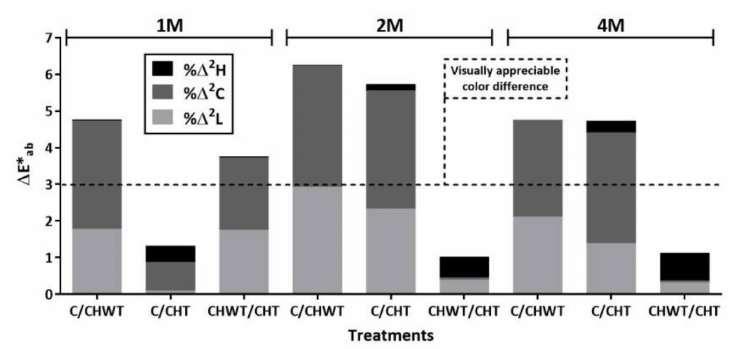
Figure 7. Color differences ( ∆ E* ab ) with the relative contributions of lightness, chroma, and hue (% ∆ 2 L, % ∆ 2 C, % ∆ 2 H) for Bonarda wines, obtained by applying different vine-shoot treatments during aging. C, control; CHWT, untoasted vine-shoot chips; CHT, toasted vine-shoot chips; 1M, 30 days; 2M, 60 days; 4M, 120